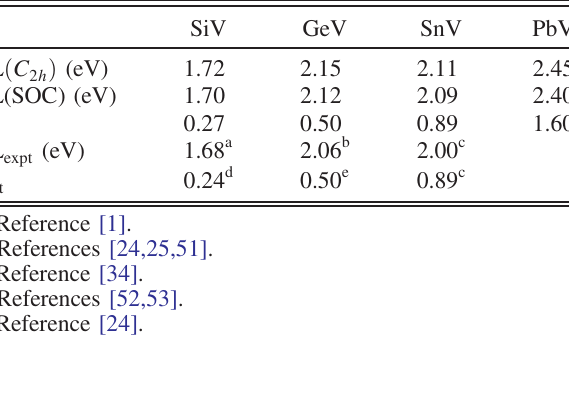
TABLE I. The calculated zero-phonon-line (ZPL) energies and HR factors ( S ) for X V ð − Þ defects are given and compared to the experimental data (ZPL and S ). Here, we provide the expt expt average ZPL values in C 2 symmetry [ZPL ð C 2 ] and within h h Þ exact calculation of dynamic Jahn-Teller (DJT) effect together with spin-orbit coupling [ZPL(SOC)]. The latter more accurate method brings our results closer to the experimental values. See text for explanation.